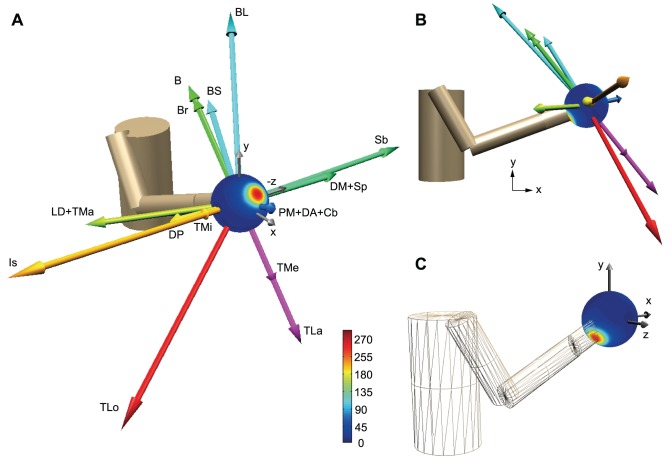
Simulation results for 3D reaching movements.(A) The arrows indicate the muscle MDVs in linear acceleration space. DP, posterior part of deltoid; DM, middle part of deltoid; DA, anterior part of deltoid; PM, pectoralis major; Cb, coracobrachialis; LD, latissimus dorsi; TMa, teres major; TMi, teres minor; Is, infraspinatus; Sb, subscapularis; Sp, supraspinatus; BS, short head of the biceps; BL, long head of the biceps; B, brachialis; Br, brachioradialis; TLa, lateral head of the triceps; TMe, medial head of the triceps; and TLo, long head of the triceps. The color gradations indicate the PD density at each point or the number of PDVs within the cone whose semi-angle is 20°. (B) Muscle MDVs viewed in the sagittal (x-y) plane. (C) PD density viewed from behind the body.